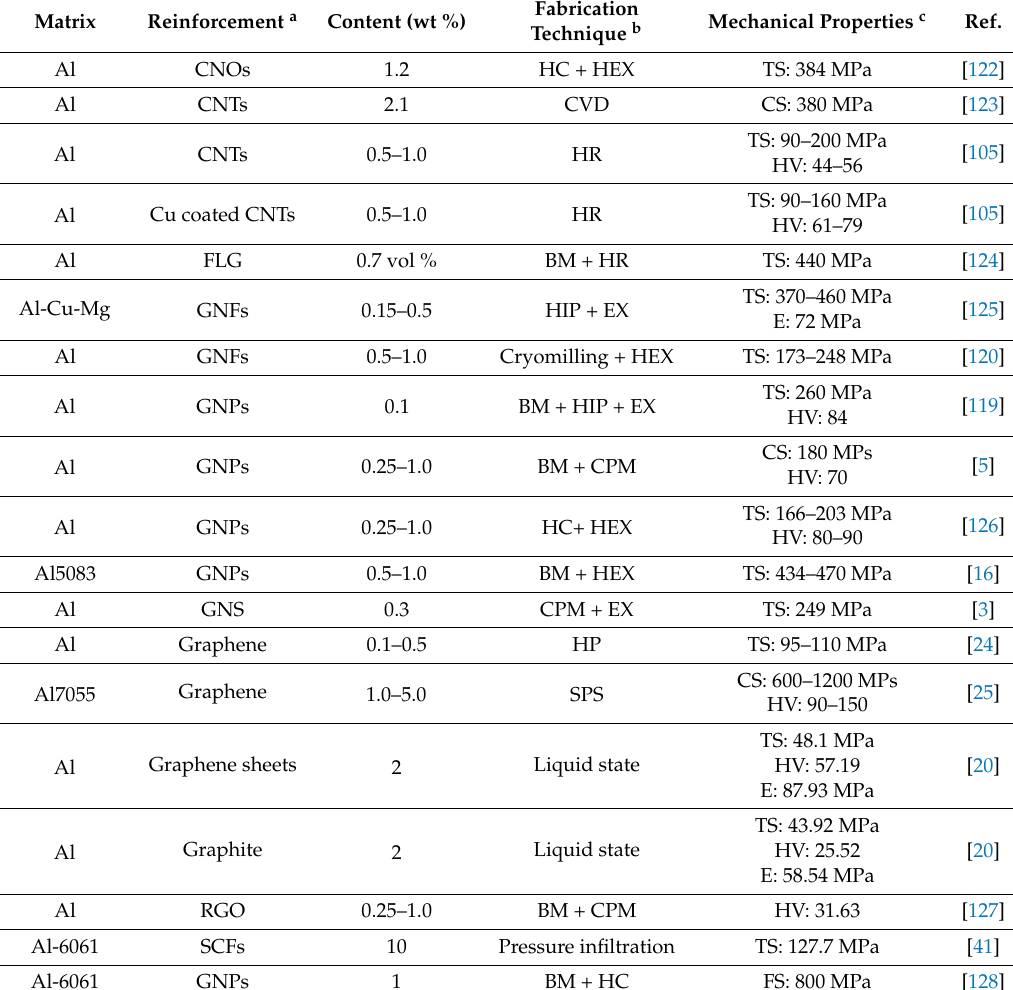
Table 2. A summary of recent research on AMCs reinforced by carbon allotropes.